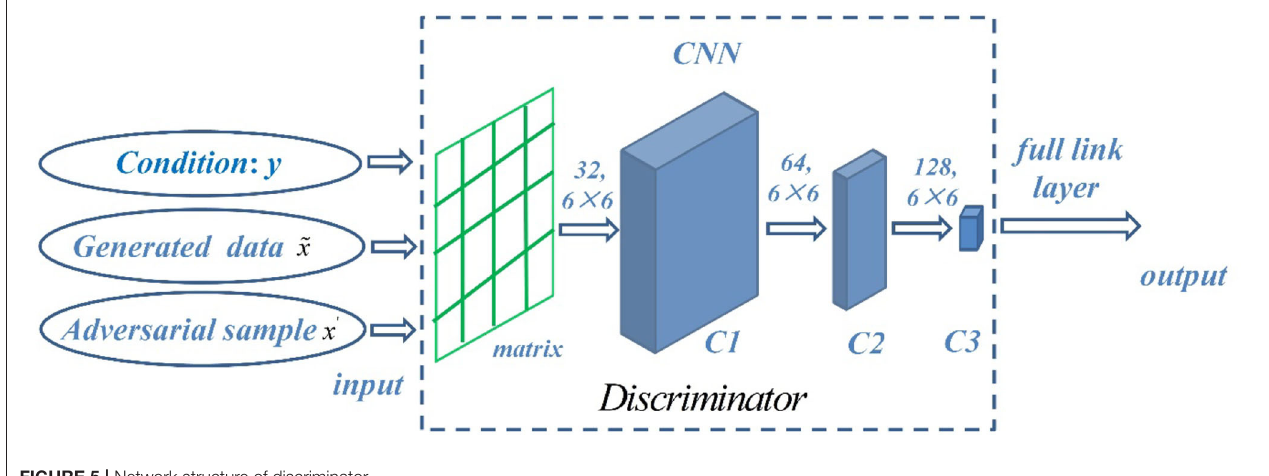
FIGURE 5 | Network structure of discriminator.